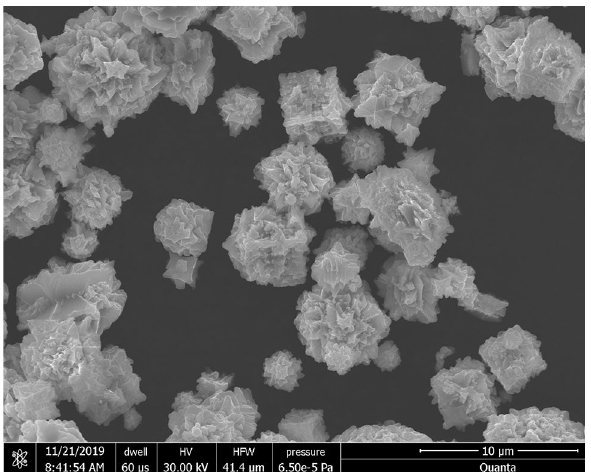
Fig. 2 Photographic image of spherical particles of carbonyl nickel